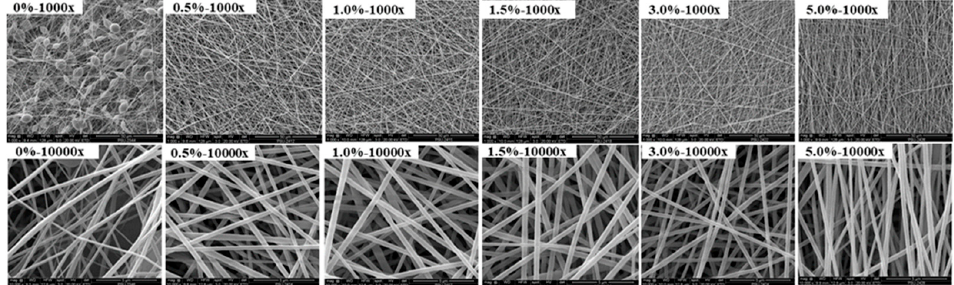
Figure 4. SEM images of pure P(VDF-HFP) and P(VDF-HFP)/PANI composite nanofibers with different PANI concentrations at (top) 1000× and (bottom) 10,000× magnifications.